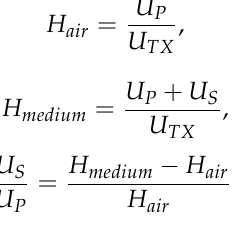
Figure 14 . Coil design used in FEM analysis: ( a ) transmitter coil; ( b ) receiver coil.